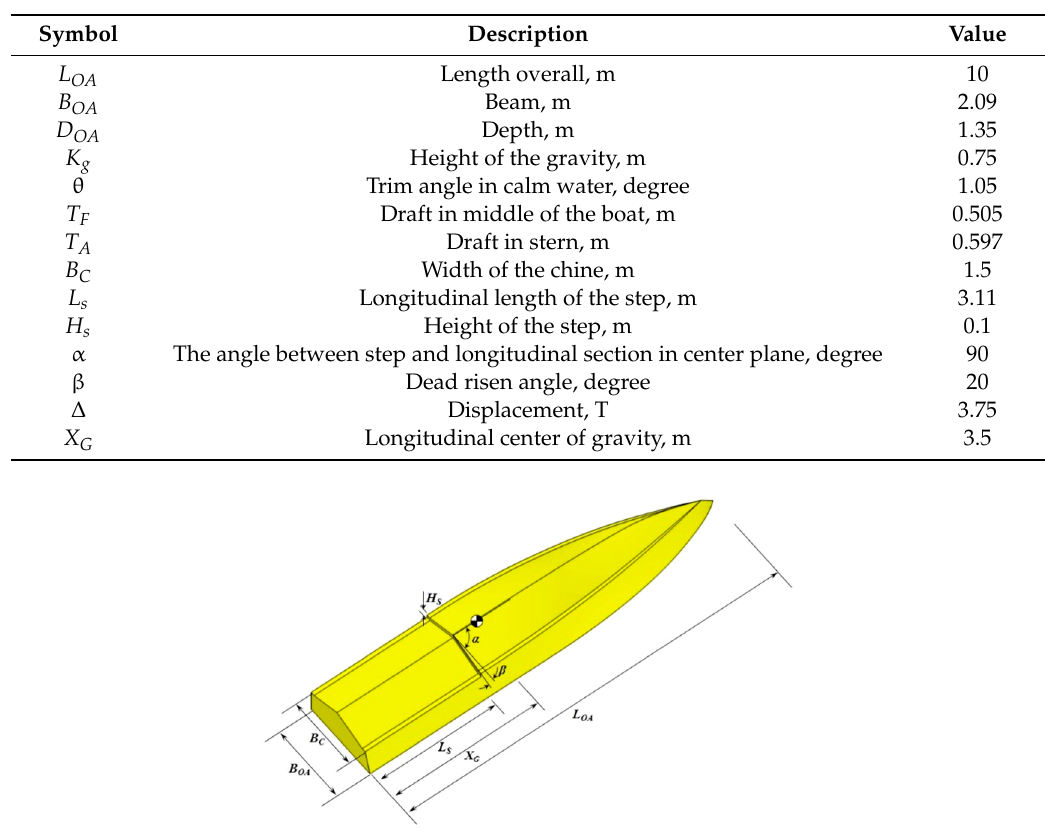
Table 1. Main dimensions of main hull in real scale.